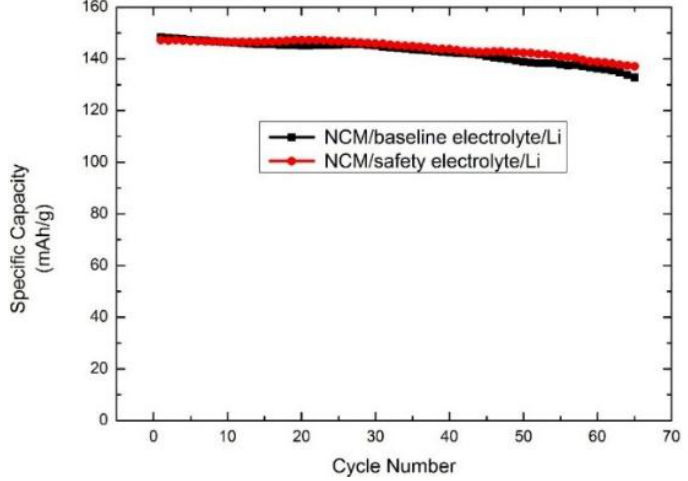
Figure 4. Cycle performance at 0.1C of NCM/baseline electrolyte electrolyte/Li and NCM/safety/Li half cells. The half cells were cycled between 2.0 V and 4.2 V at half cells. The half cells were cycled between 2.0 V and 4.2 V at 0.1C.